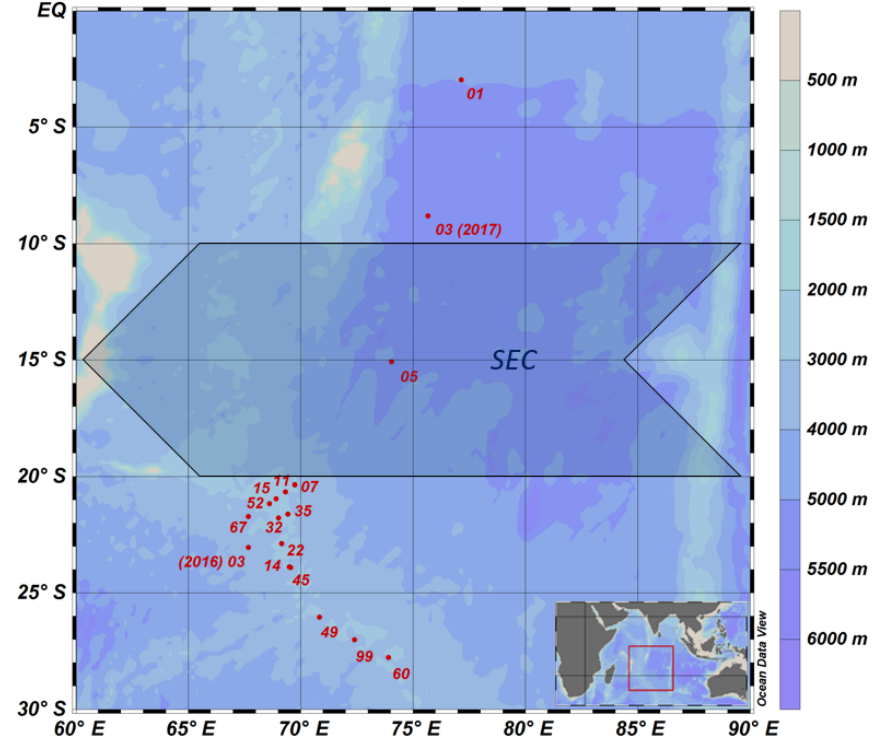
Figure 1. Sampling location during the MSM 59/2 (INDEX 2016-2) and SO 259 (INDEX 2017) cruises. The shaded arrow represents the westward-directed, broad South Equatorial Current (SEC) following Woodberry (1989) from 10 to 20 ◦ S. Colours denote water